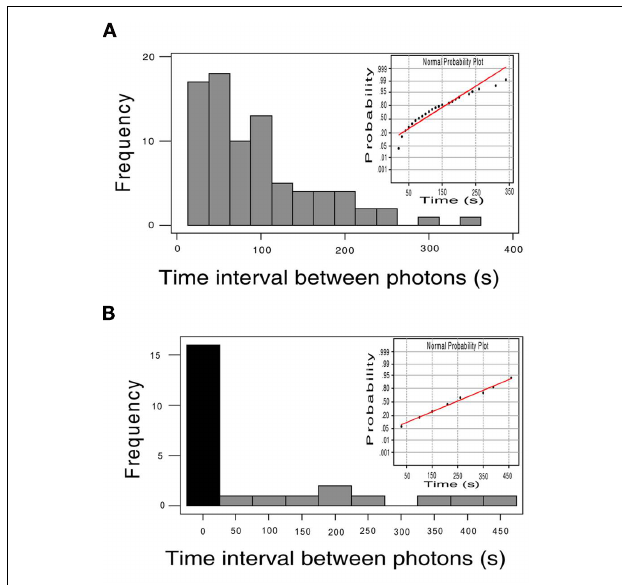
FIGURE 4 |Temporal dynamics of single-photon emissions differ inside and outside localized areas of repeated photon emissions. (A) Repeated emission of photons from localized regions of axons was observed (hot spots). Photon emissions from 15 μ m diameter regions of interest appeared at mean intervals of 95.1 ± 70.18s (SD), but the frequency distribution was multimodal and highly skewed toward shorter intervals.The frequency distribution of photon emissions from hot spots was significantly different from a normal distribution ( R = 9.437 on a normal probability plot (shown in inset), A 2 = 3.037, p < 0.0001, Anderson–Darling normality test)), and the coefficient of dispersion was 51.8, departing substantially from the CD = 1 of a Poisson distribution. (B) Outside hot spots, photon emissions were much less frequent and the frequency distribution of these events could not be distinguished from a normal distribution. No photon emissions were detected from many 15 μ m diameter regions of interest sampled over a period of 10min (black bar) in the same microscope fields in which hot spots were analyzed. Photons detected from regions outside hot spots appeared at a mean interval of 240 ± 140s (SD), significantly longer intervals than repeated emissions from within hot spots ( p < 0.01 by t -test and p < 0.0001 by Mann–Whitney U non-parametric test). In contrast to the frequency distribution of photon events from within hot spots, outside these regions the normal distribution of photon emissions could not be distinguished from a normal distribution ( R = 0.9949 on a normal probability plot (inset), A 2 = 0.157, p = 0.925, Anderson–Darling normality test).The coefficient of variation was much lower outside hot spots than inside (CV = 0.583 vs.